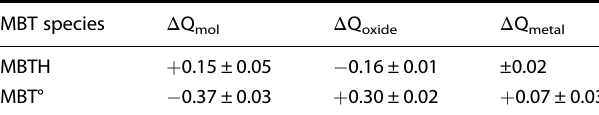
Table 2. Bader charge analysis for MBTH and MBT ∘ species. Δ Q mol , Δ Q Δ Q oxide and metal correspond to the Bader charge analysis on the molecule, oxide and the metal, respectively, in electron/molecule.